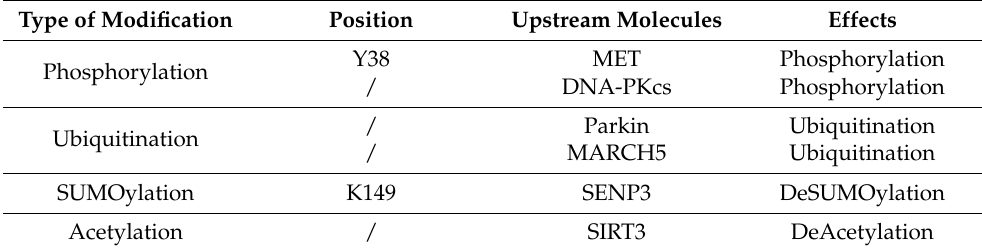
Table 1. Post-translational modifications of